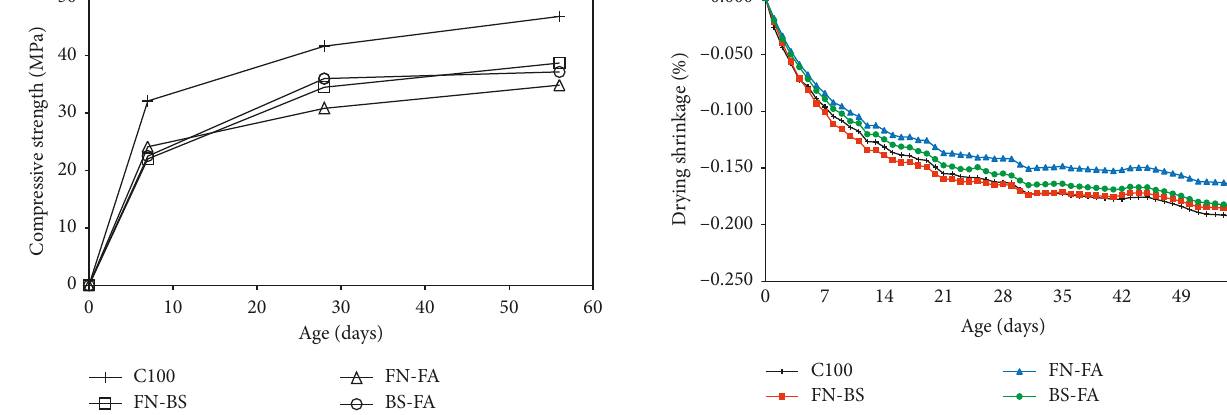
Figure 9: Compressive strength of the ternary mortar (Series II).